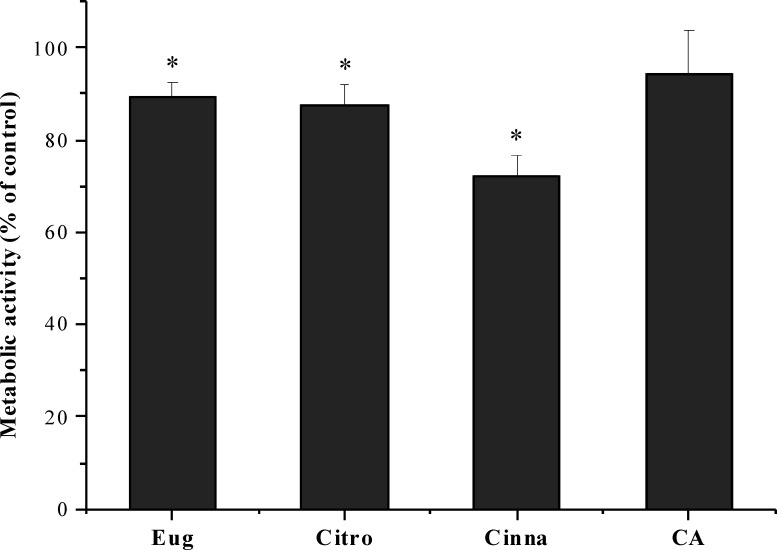
Influence of eugenol, citronellol, trans-cinnamaldehyde and cinnamic acid on fibroblast cells viability, as a percentage of cells on control.*P < 0.05, significant reduction compared to control DMSO (5%, v/v). Eugenol (Eug), citronellol (Citro), trans-cinnamaldehyde (Cinna), and cinnamic acid (CA).